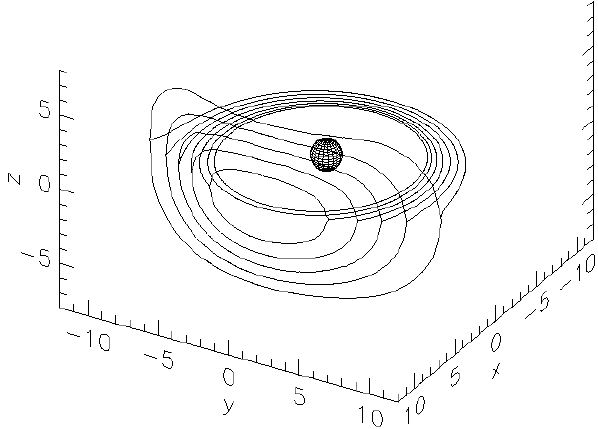
Fig. 1. The configuration of B =const isolines, calculated using Tsyganenko-2004 model and solar wind parameters P SW =2nPa, IMF B Z = − 5nT, B Y = B X =0 and zero inclination of Earth’s mag- netic